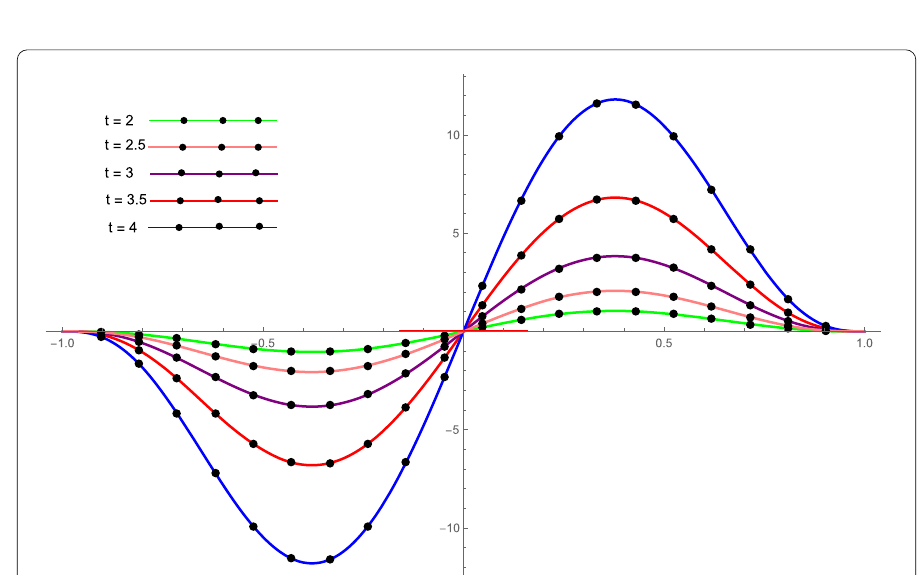
Figure 6 Exact and approximate solutions for Example 2 when N = 100, (cid:3) t = 0.001, α = 0.6, and –1 ≤ z ≤ 1